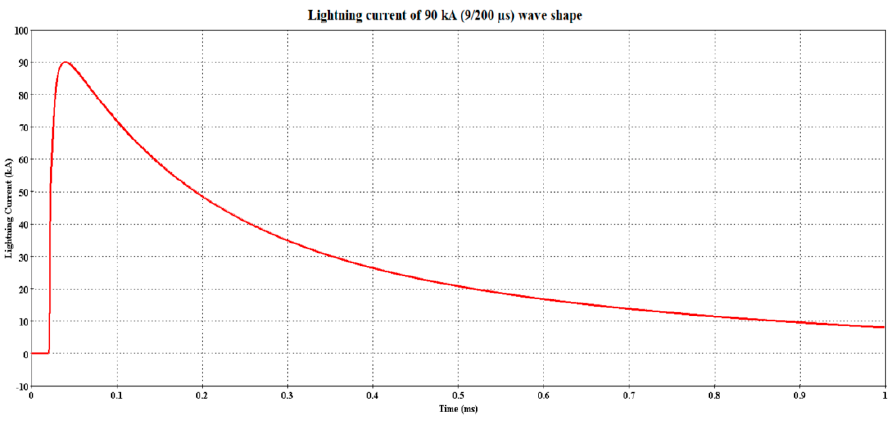
Figure 5. Lightning current 90 kA (9/200 µs) waveshape.